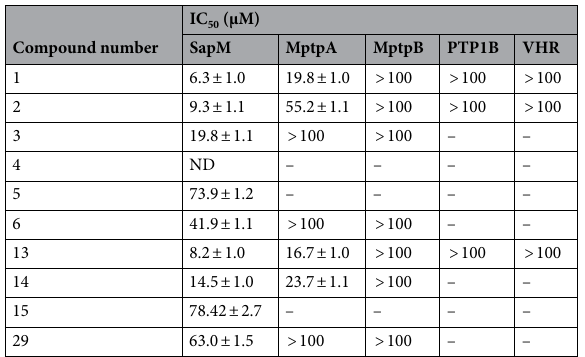
Table 3. Selectivity of SapM inhibitors towards phosphatases. Inhibition of selected compounds towards mycobacterial secreted phosphatases SapM, MptpA and MptpB, and human phosphatases PTP1B and VHR. IC 50 values are mean ± SD of two independent experiments. ND not determined as compound precipitates at concentrations > 100 µM.